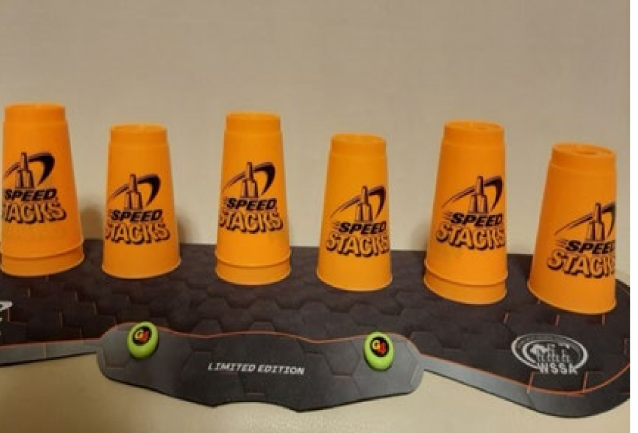
Figure 3. From left to right, lift the cup at the top of each stack with the right hand, and set it next to the cup at the bottom of the stack.